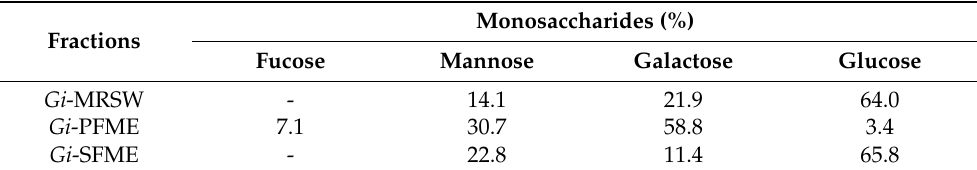
Table 1. Monosaccharide compositions of the cold-water-soluble fractions obtained from the basid- iomata of Gymnopilus imperialis .